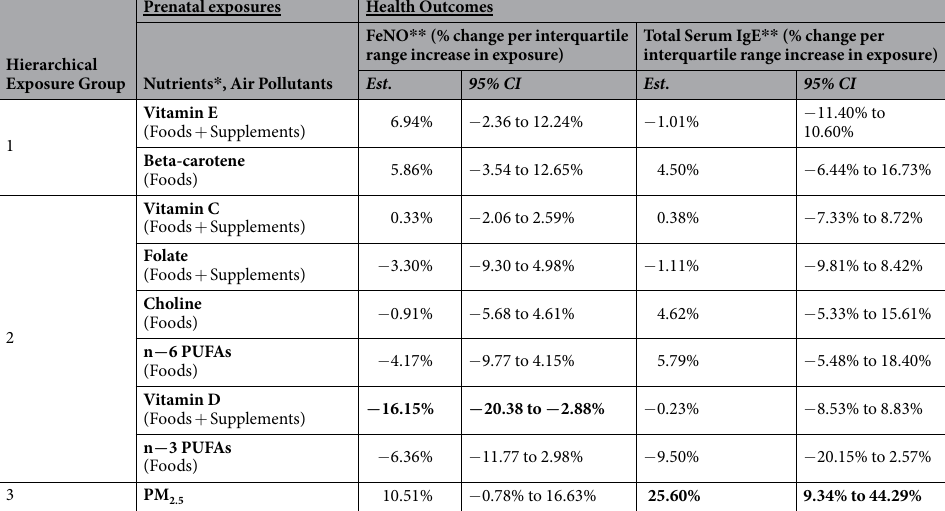
Table 4. BKMR Estimates for associations of Prenatal Nutrient Intakes (Foods + Supplements) and Prenatal Air Pollutant (3 rd Trimester PM2.5) Exposure with Allergic Disease Outcomes (FeNO and Total Serum IgE) in adolescence. * Supplement data was not available for all nutrients. ** Adjusted for maternal pre-pregnancy BMI, education, hay fever, and pregnancy smoking status (never, former, smoked during pregnancy); season of birth, sine and cosine of date at outcome measurement; and child’s race/ethnicity and sex. Estimates with p < 0.05 are in bold.